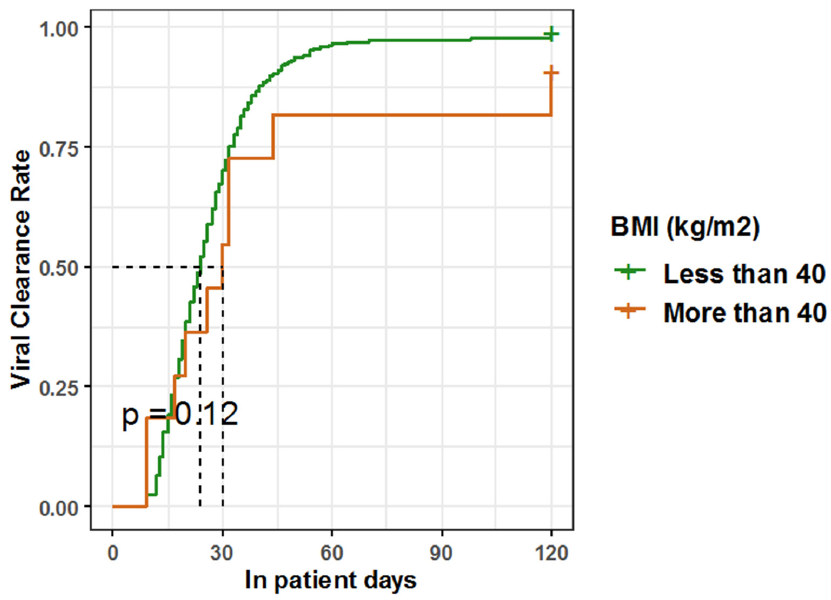
Figure 10. Kaplan ‒ Meier estimate for time to viral clearance among hospitalized COVID ‐ 19 patients with a BMI of more than 40 versus less than